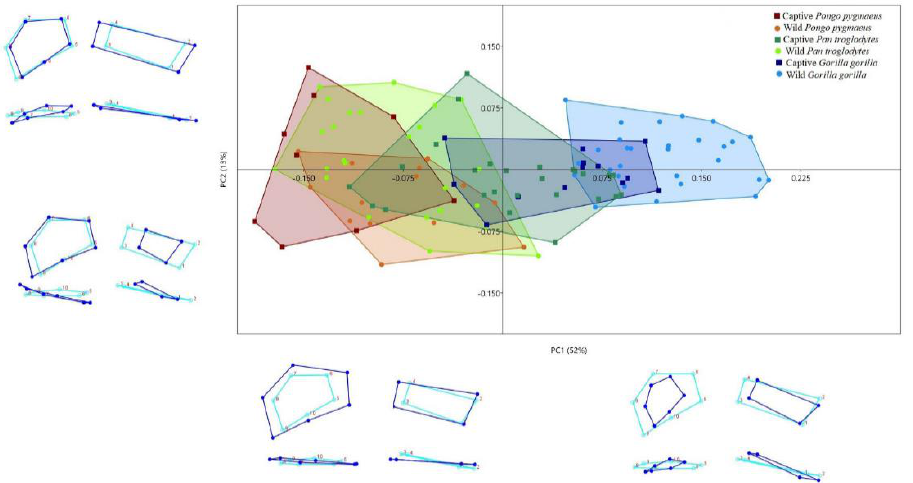
Figure 2. Convex Hull of PC1 vs. PC2 derived from the PCA of the 3D GM analysis. Dark blue wireframes show the extreme shape of each PC in a palmar view (upper panel) and a proximal view (lower panel). Light blue wireframes show the mean shape (coordinates 0.0).